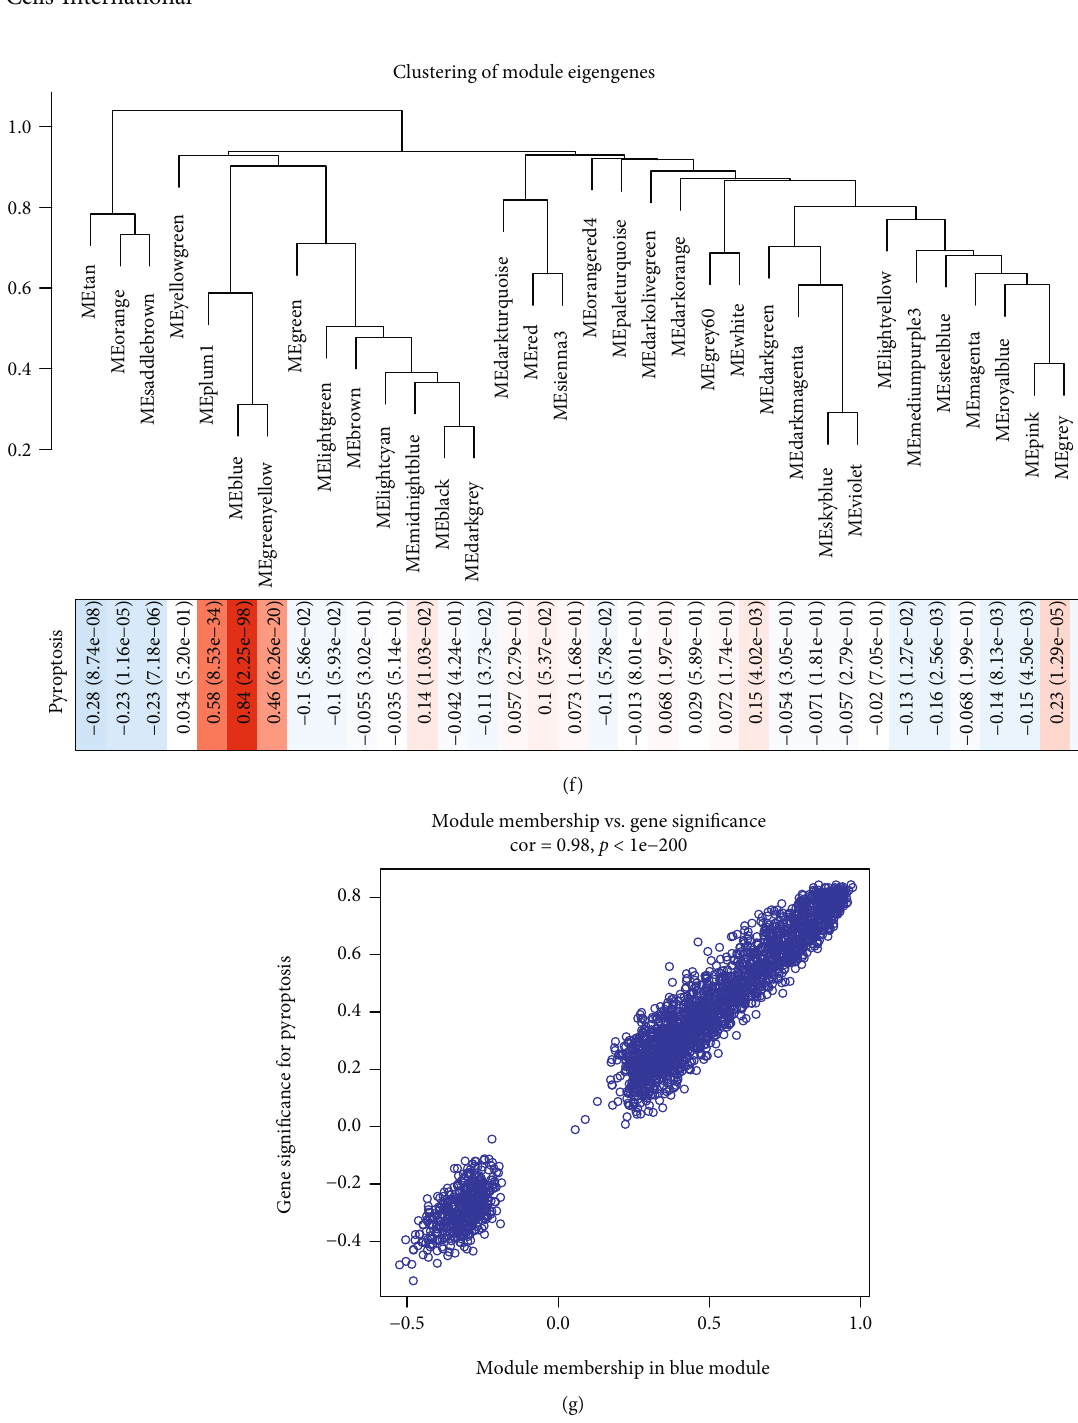
Figure 3: WGCNA on genes related to the pyroptosis-associated pro fi les among melanoma cases in TCGA-SKCM cohorts. (a) Clustering tree of each sample. (b) Analysis of the scale-free fi t index for various soft-thresholding powers ( β ). (c) Analysis of the mean connectivity for various soft-thresholding powers. (d) Dendrogram of all di ff erentially expressed genes clustered based on a dissimilarity measure (1-TOM). (e) Gene numbers within those 34 coexpression gene modules. (f) Heat map presenting the relations of modules with scores of pyroptosis- associated pro fi les. (g) Scatter diagram for module membership vs. gene signi fi cance in the blue